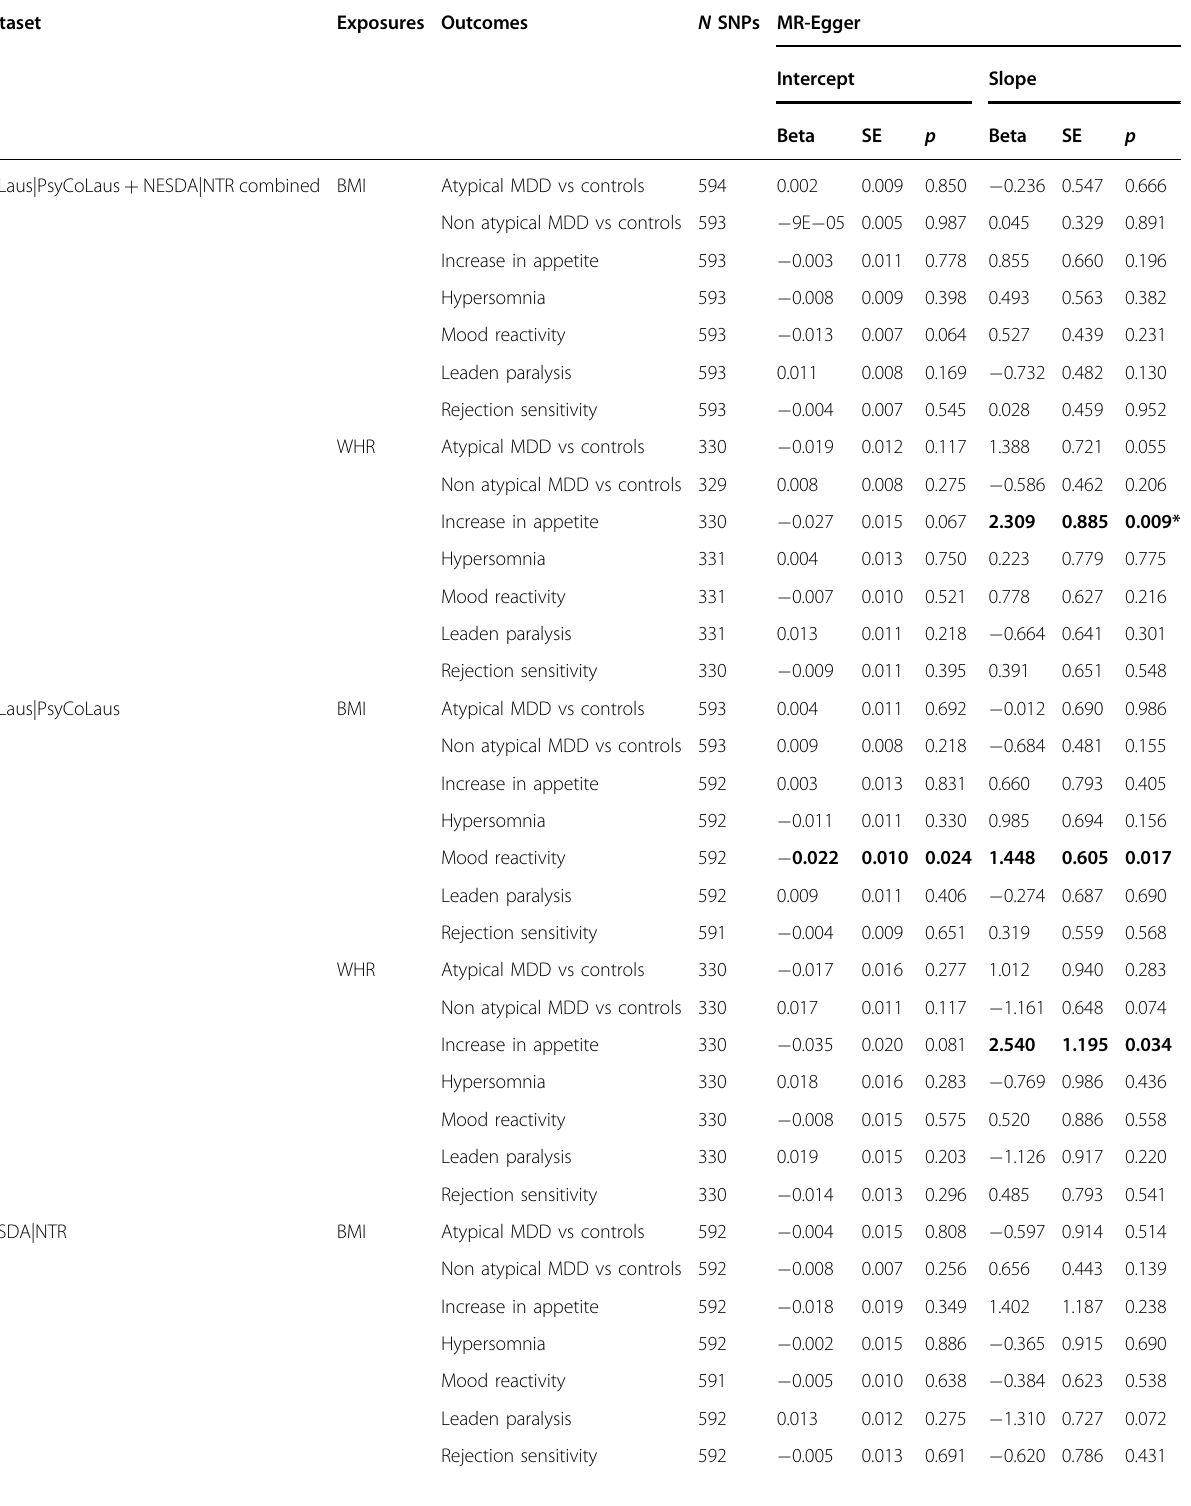
Table 3 Results of the Mendelian Randomization analyses using the MR-Egger method in CoLaus|PsyCoLaus, NESDA| NTR, and in their combined